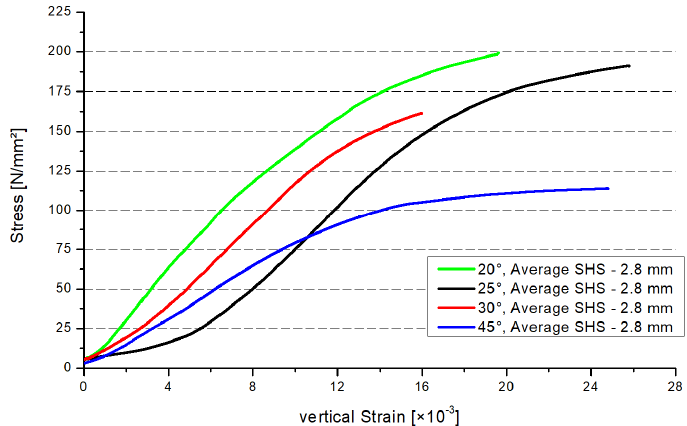
Figure 5. Stress–strain distributions.